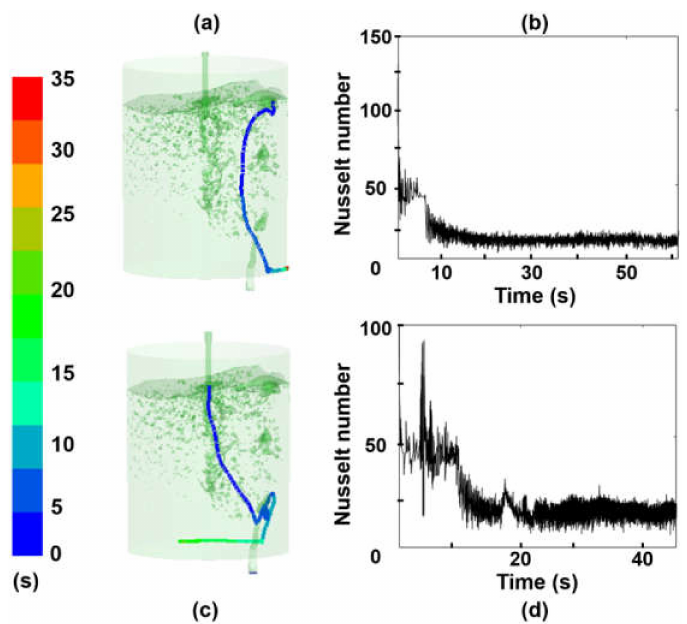
Figure 5. Particle trajectories, residence times, and Nusselt numbers at a bath level of 80 tons. ( a ) A 3D view of the multiphase flow when the particle falls point N3. ( b ) Variations of Nusselt number with time at falling point N3. ( c ) A 3D view of the multiphase flow when the particle falls point E1. ( d ) Variations of Nusselt number with time at falling point E1.